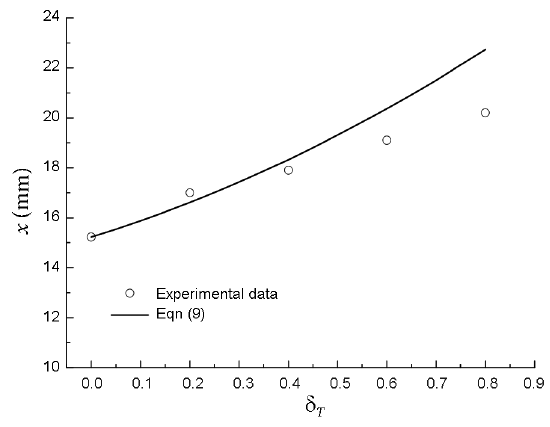
Figure 13. Comparison between the computed results from Eqn (9) and the experimental data from Xue (2016)